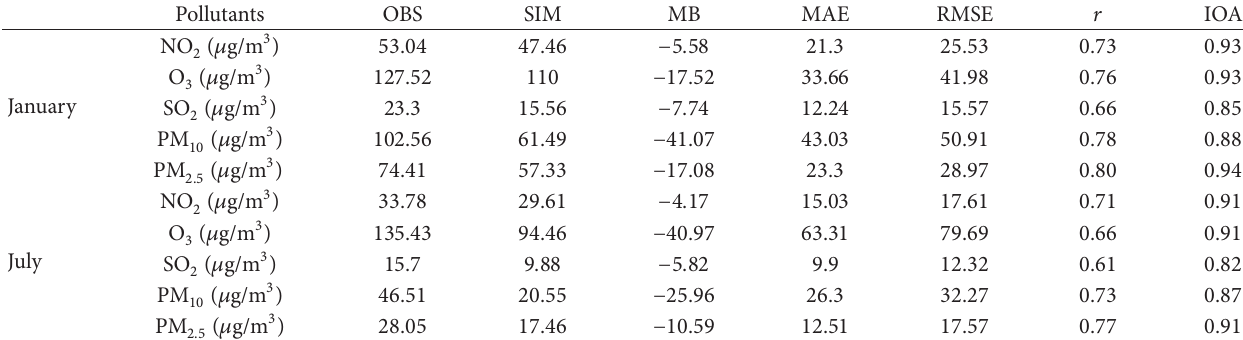
Table 2: Comparison of simulated and observed concentrations of SO 2 , NO 2 , O 3 , PM 2.5 , and PM 10